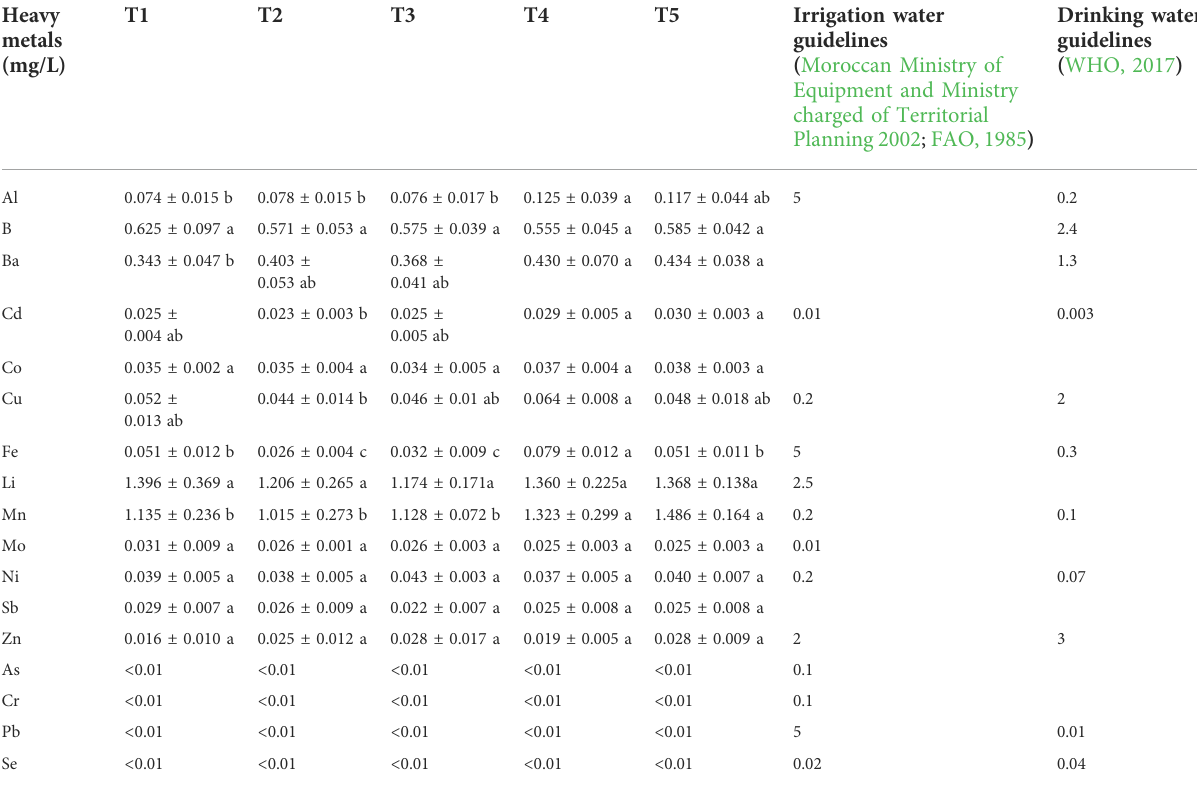
TABLE 6 Heavy metals contents of leachate of Sidi El Mokhtar soil for different treatments. Same letters in a line series indicate no signi fi cant differences among treatments ( p < 0.05, S-N-K ’ s test). Heavy metals